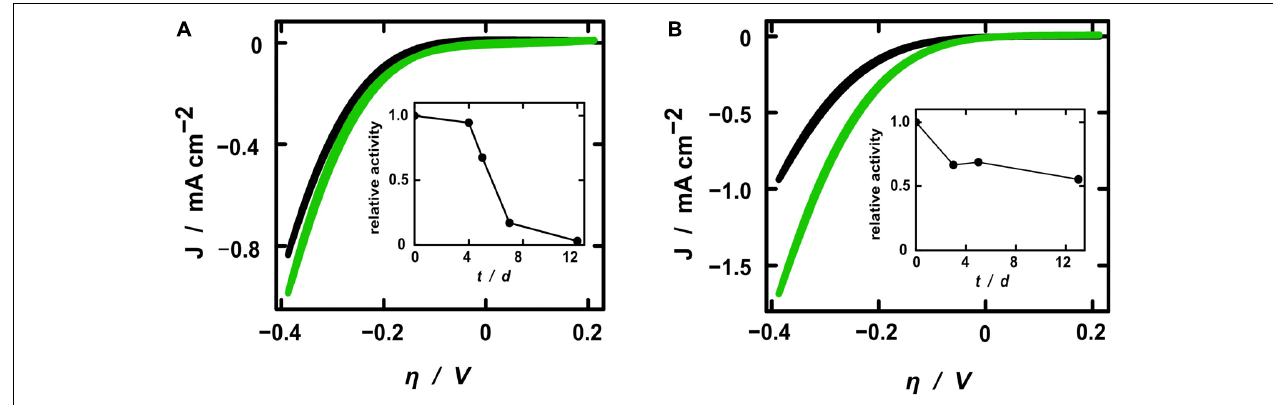
FIGURE 4 | Cyclic voltammograms of electrospun fibers coated with TiO 2 . Current densities are shown for electrodes without (black curves) and with diluted H 2 -evolution active membrane fractions (green) of clone P5H2 [ (A) , harboring the S. oneidensis wild type hydrogenase] and SP11F2 [ (B) , harboring an unknown hydrogen converting enzyme]. Note that always the 20th CV cycle (reaching a stable state) is shown. Additionally, the stability of the H 2 -evolving enzymes is displayed as the relative activities of electrodes coated with the diluted membrane fractions of P5H2 (A) and SP11F2 (B) . At each time point the same electrochemical investigations (Cyclic voltammetry and electrolysis) were performed without any further